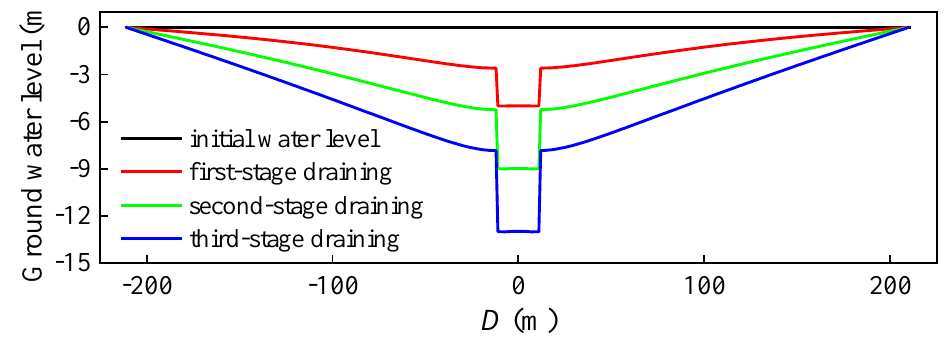
Figure 6. Drawdown curves of groundwater in the excavation for different construction stages.